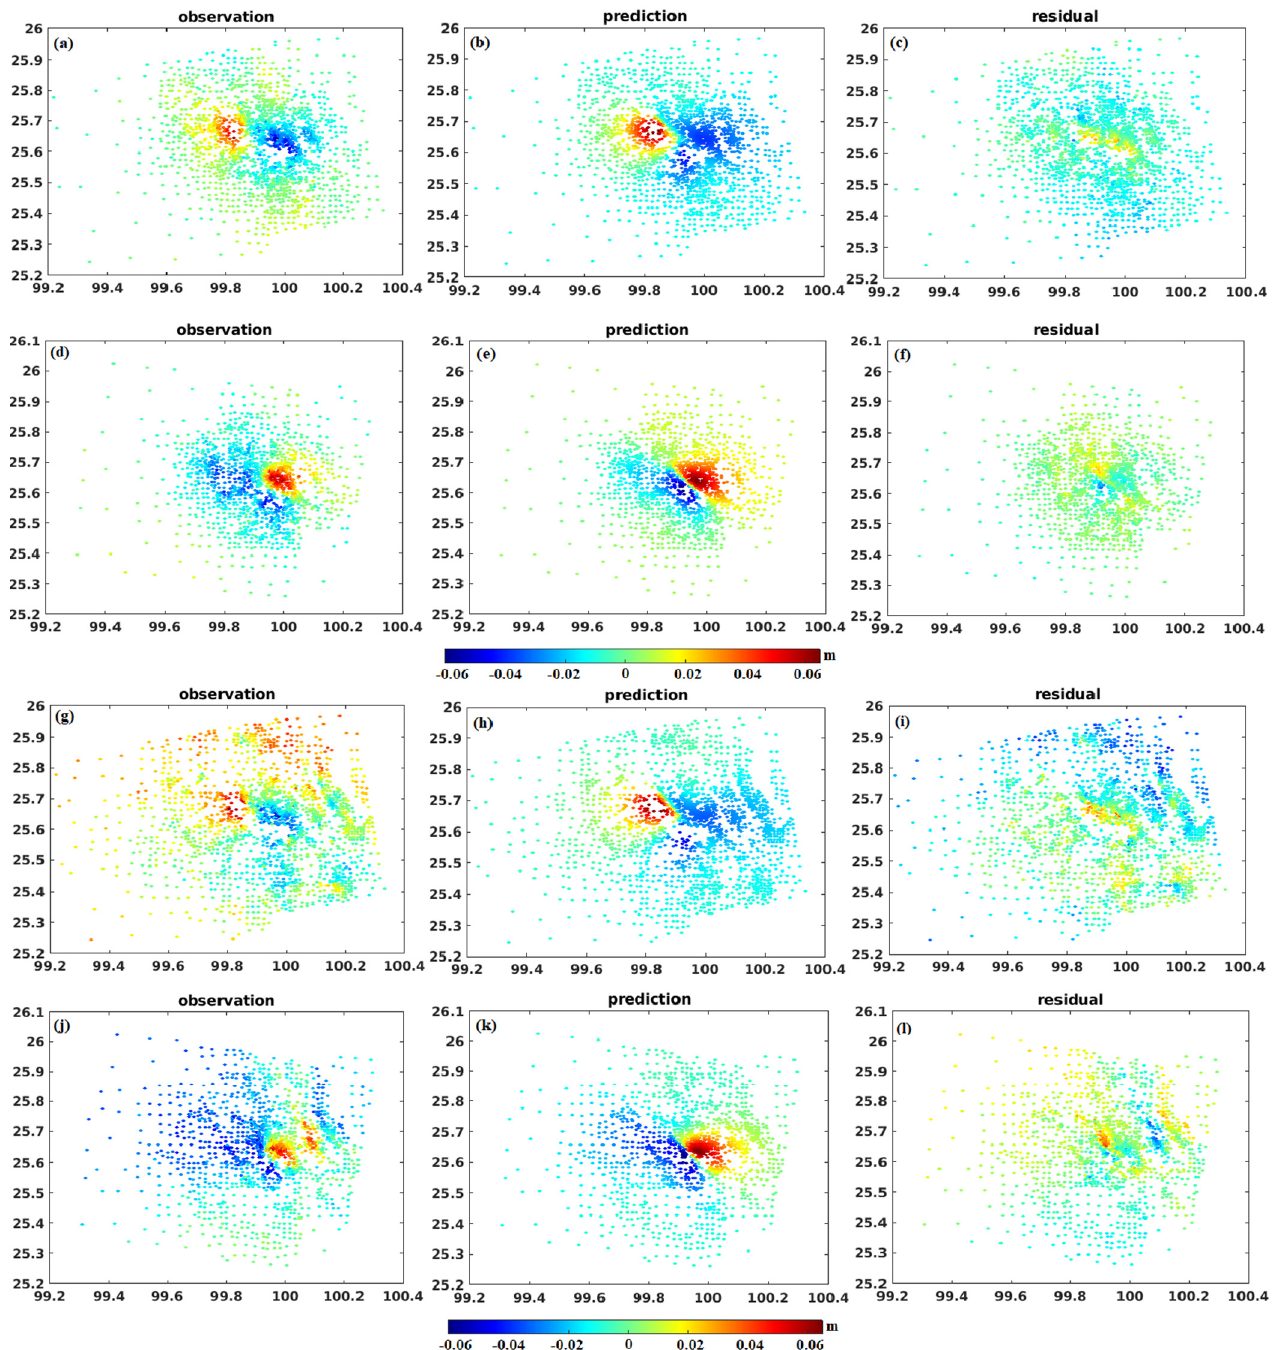
Figure 8. LOS coseismic deformation model fitting results based on the time-series InSAR and D–InSAR deformation datasets: ( a – c ) represent ascending LOS deformation observations, predicted model values, and residuals, respectively; all are based on time–series InSAR data; ( d – f ) represent descending LOS deformation observations, model values, and residuals, respectively, based on time-series InSAR data; ( g – i ) represent ascending LOS deformation observations, model values, and residuals, respectively, based on D–InSAR data; and ( j – l ) represent descending LOS deformation observations, model values, and residuals, respectively, based on D–InSAR data.